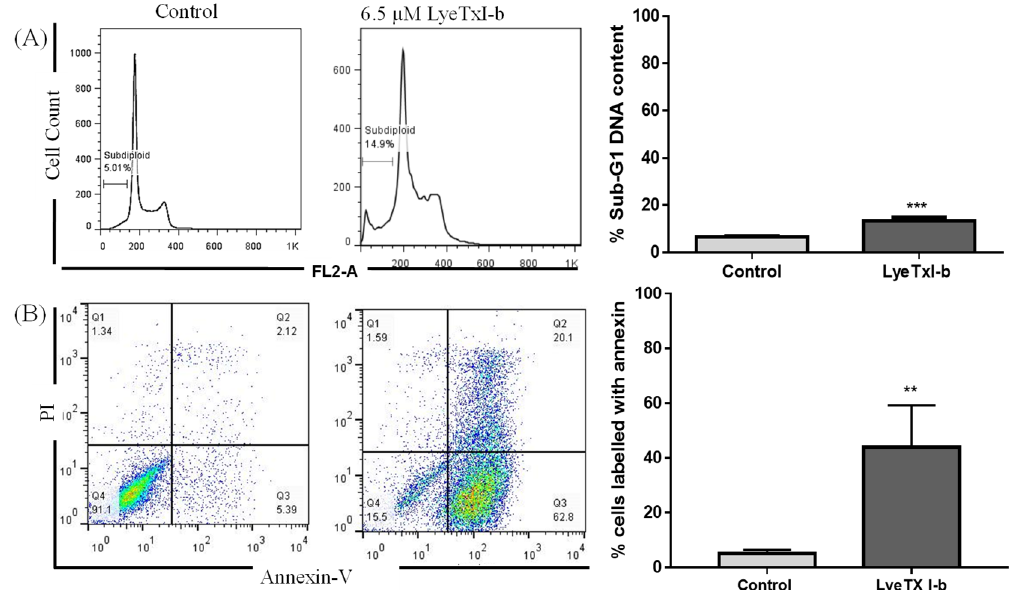
Figure 2. ( A ) Representative histograms of cell cycle analysis after exposure to LyeTx I-b and carboplatin at IC 50 values for 48 h. The results represent three independent experiments in triplicate and show significant differences between the negative control and the treated cells in terms of the G0/G1 (sub-diploid) population. ( B ) Illustrative histogram representing the quantification of the proportions of the dead and live cells after exposure of 4T1 cells to 6.5 µM of LyeTx I-b for 24 h and staining with annexin V/Propidium iodide (PI). The number of cells in each quadrant (Q) gate can be quantified as follows: Q4 = live cells (PI negative/annexin V negative); Q3 = apoptotic cells (PI negative/annexin V positive); Q2 = necrotic or late apoptotic cells (PI positive/annexin V positive); and, eventually, Q1 = nuclei without plasma membrane = (PI positive/annexin V negative). Three independent experiments in triplicate and unpaired t-test were performed, ** p < 0.01; *** p < 0.001 compared to the control group.